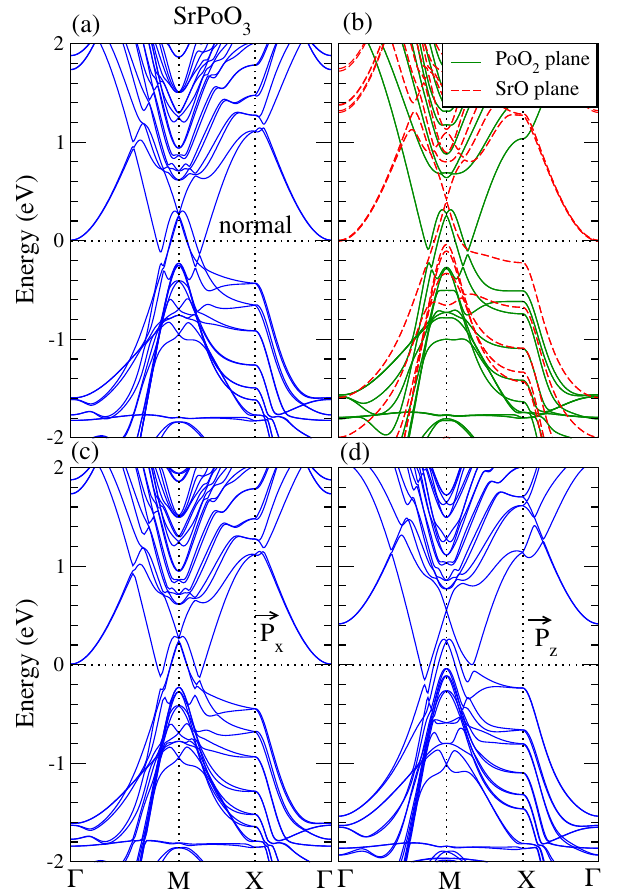
Figure 6. ( a ) Calculated fully relativistic band structure for the SrPoO 3 supercell. ( b ) Fully relativistic band structures with PoO 2 surfaces on both sides, green solid-lines, and SrO surfaces on both sides, red-dashed lines. ( c , d ) Fully relativistic band structures with Po atoms moving in-plane and out-of-plane,